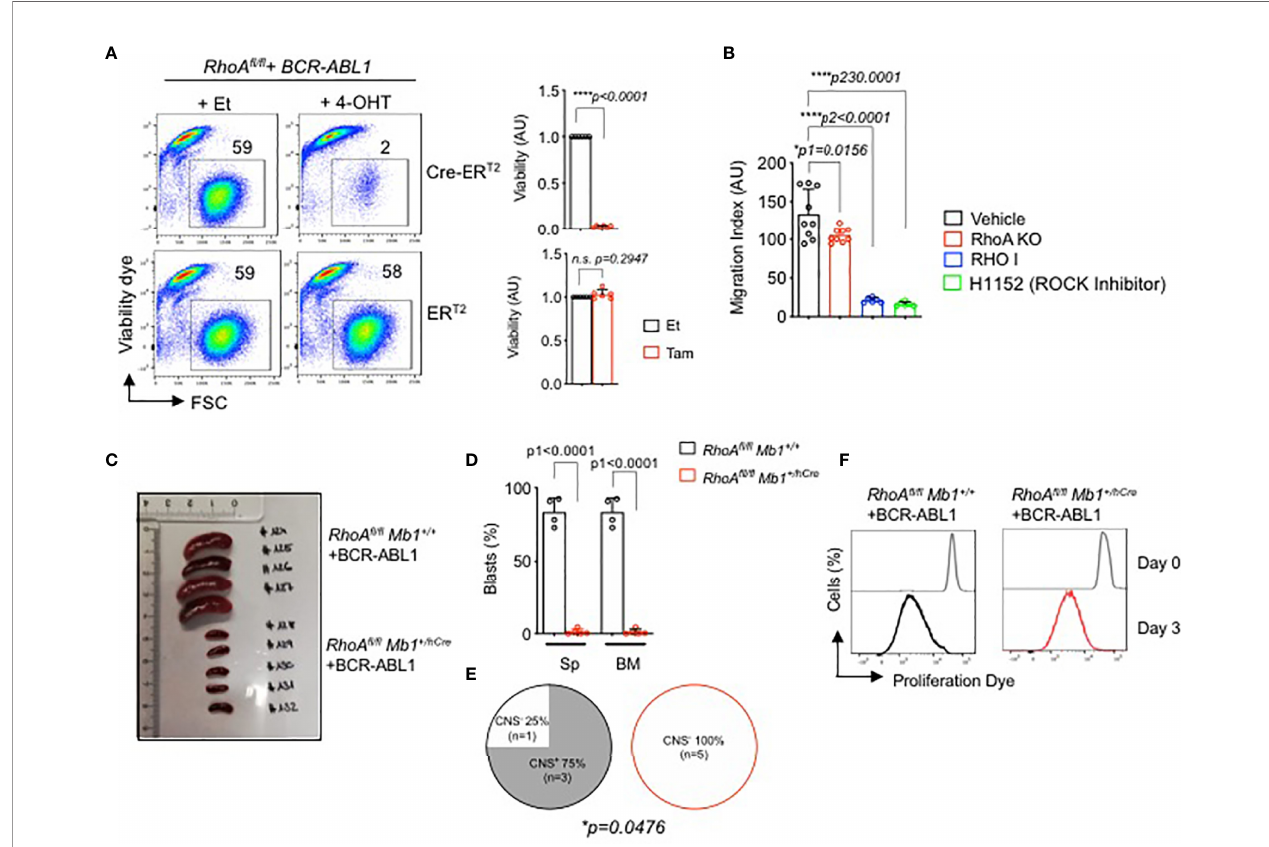
FIGURE 6 | RHOA is required for BCR-ABL1-induced pre-B cell transformation. (A) RhoA fl / fl pre-B cells were transformed with BCR-ABL1 and were then transduced with Cre-ER T2 . Cells were treated with either 4-OHT to induce Cre expression, or with Et. Left- The percentage of living cells were determined by fl ow cytometry using Sytox as an excluding dead cell stain. Right- quanti fi cation of the percentage of living cells after 3 days of tamoxifen induction relative to control cell. N=6 independent samples per group, and error bars represent mean ± SD. AU: arbitrary unit. (B) RhoA fl / fl -BCR-ABL1 transformed cells were treated with RHO inhibitor (RHO I, 2µg/ml), H1152 (ROCK inhibitor H1152, 5µM) or with vehicle for 16 hours, then were subjected to migration gradient toward CXCL12 (100ng/ml) for 16 hours . RhoA fl / fl Mb1 +/hCre -BCR-ABL1 + cells were also used for migration assay. The cells that migrated in the lower chamber were counted by trypan blue. (C, D) . RhoA fl / fl and RhoA fl / fl Mb1 +/hCre pre-B cells were transformed with BCR-ABL1 and were then injected intravenously into immunode fi cient RAG2 -/- g c -/- mice. The mice were sacri fi ced after three weeks when the control mice showed leukemic symptoms. (C) Spleen (Sp) size. (D) Quanti fi cation of total number of BCR-ABL1+ cells in the Sp and bone marrow (BM). (E) CNS-in fi ltration as assessed by semi-quantitative scoring (D, E) . Statistical signi fi cance was determined using unpaired